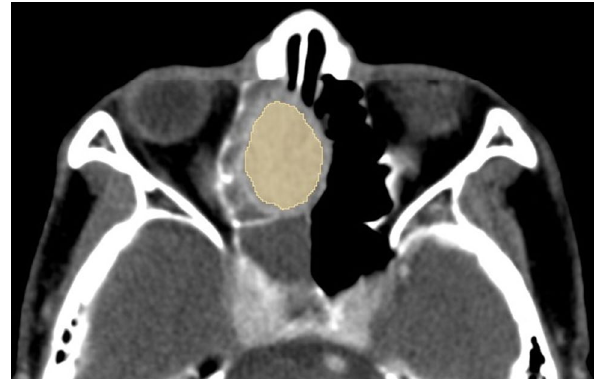
Figure 1. Representative example of a patient with ONB. The manually drawn ROI (in yellow) is delineated on an axial CECT